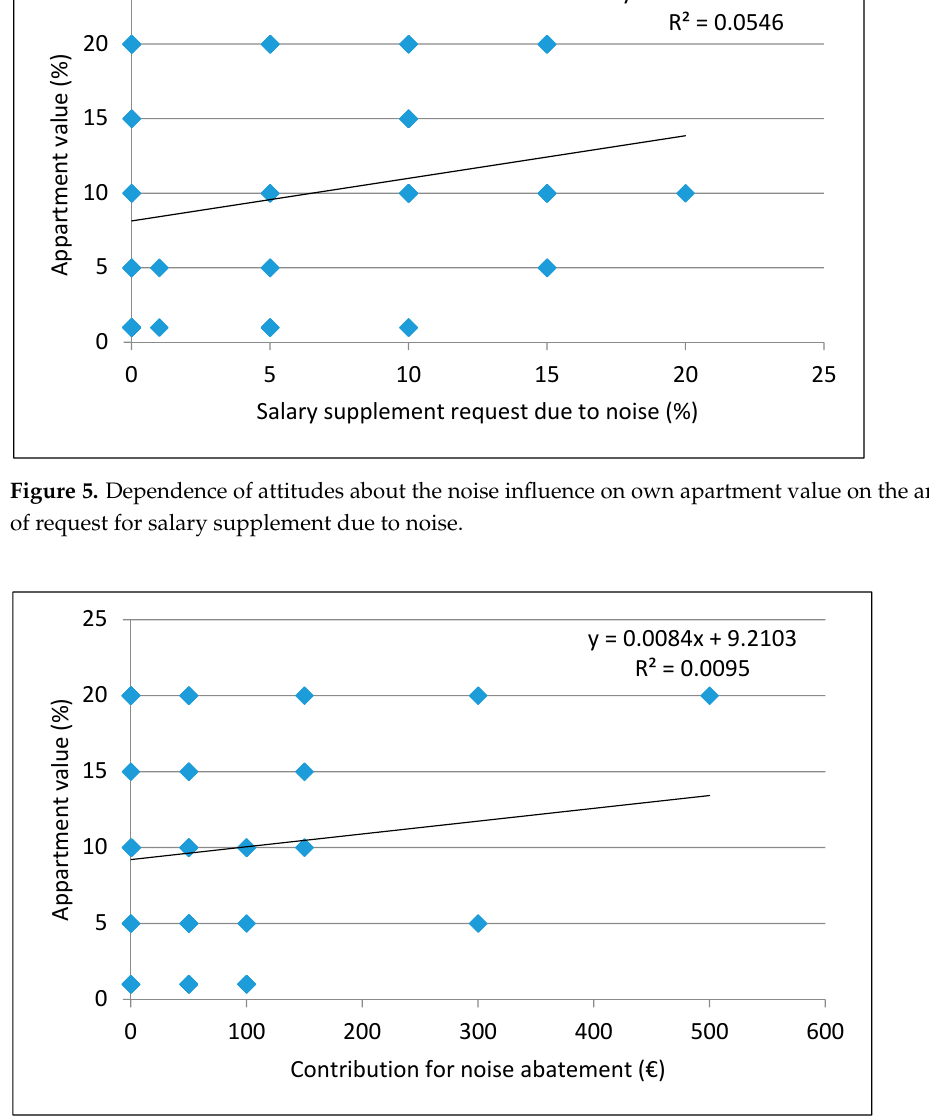
Figure 6. Dependence of attitudes about the noise influence on own apartment value on the declared contribution for noise abatement